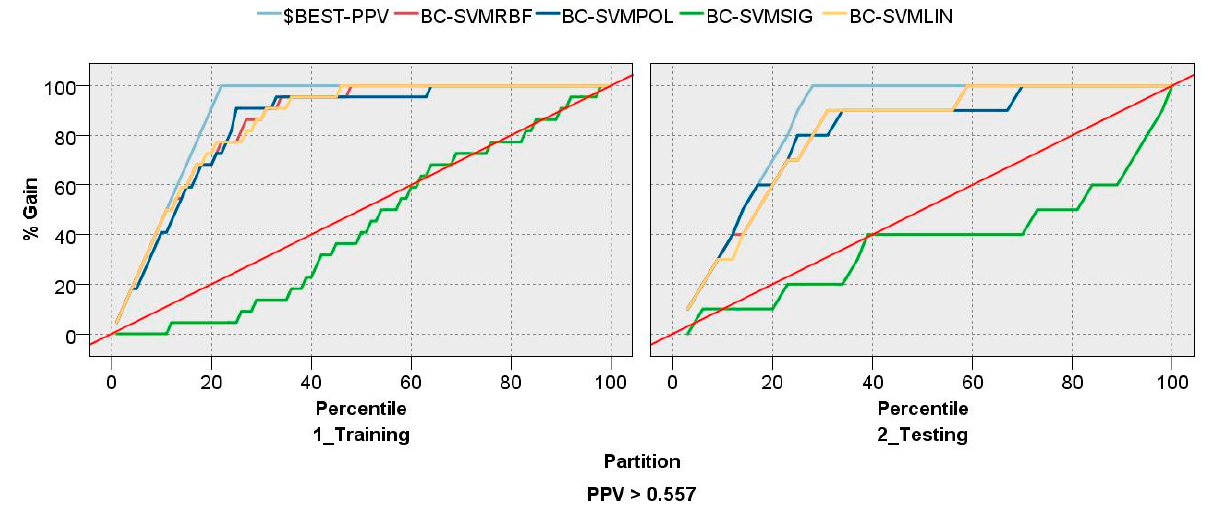
Figure 8. Gain chart of the proposed models.